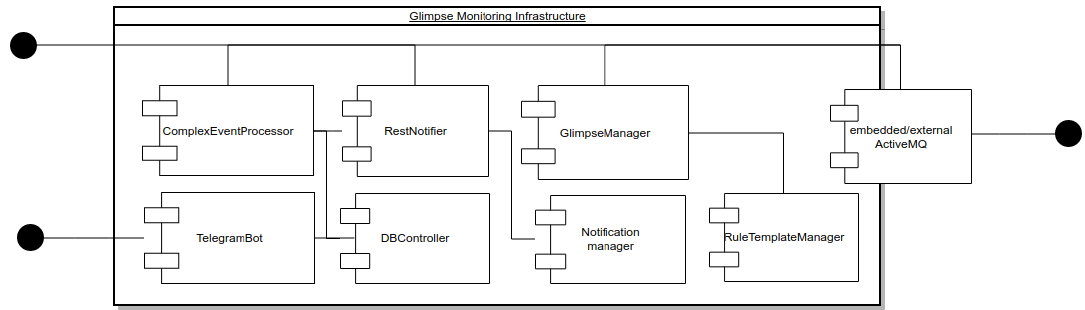
Figure 4. Glimpse monitoring infrastructure